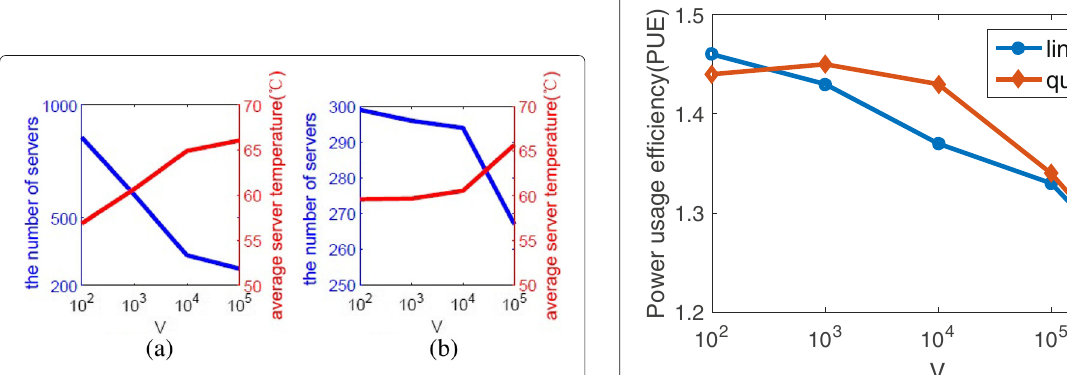
efficient in both the total energy and the component energy. The conclusion based on the metric PUE is oppo- site to the state of actual energy consumption. Hence, the metric PUE accepted by the field experts is not enough to diagnose whether a data center is efficient or not.